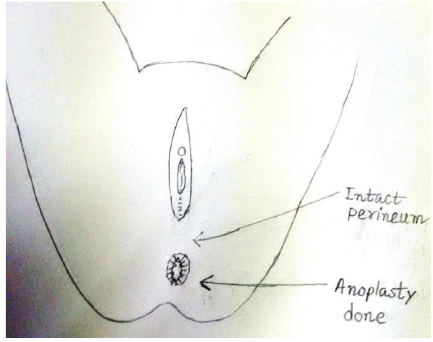
Figure 13: Anoplasty